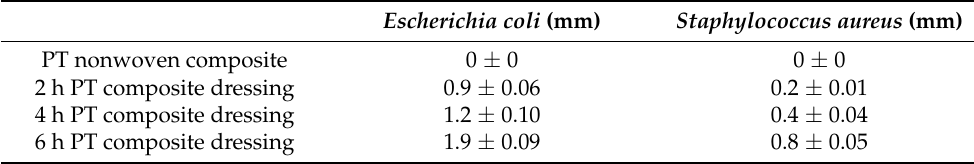
Table 2. The antibacterial property of PT nonwoven dressing with different reaction